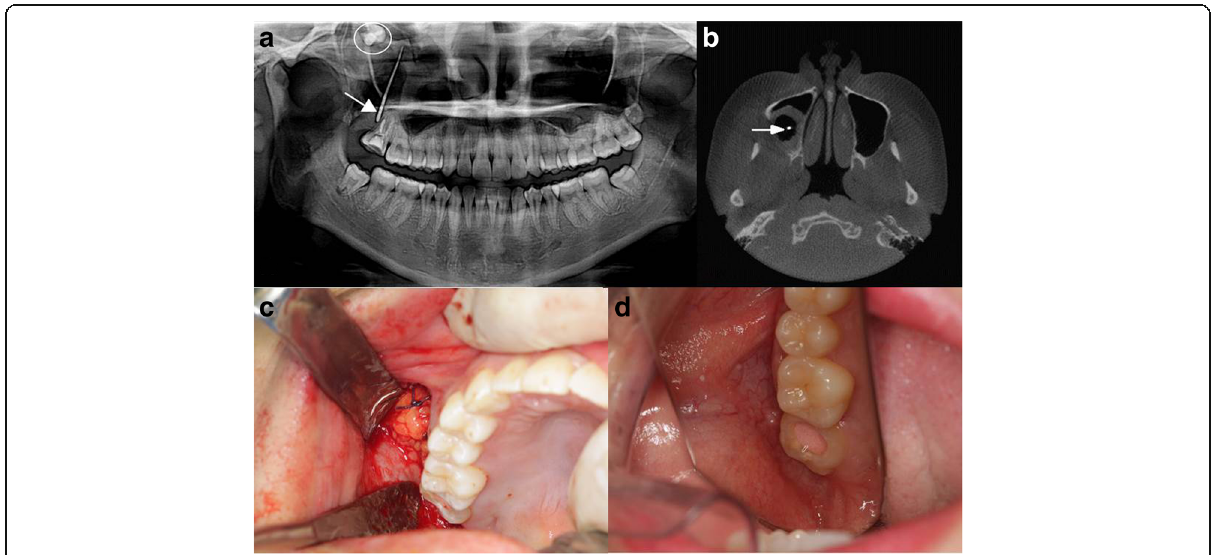
Fig. 1 Case 1. a Panoramic view shows an oroantral fistula between the oral cavity and right maxillary sinus cavity (arrow indicates the gutta-percha cone). Additionally, full impaction of no. 18 was observed in the sinus cavity (circle). b Computed tomography showing right sinusitis and gutta-percha cone for examination (arrow). c The defect was reconstructed with pedicled buccal fat pad. d After 3 months, the operation site was successfully closed and well